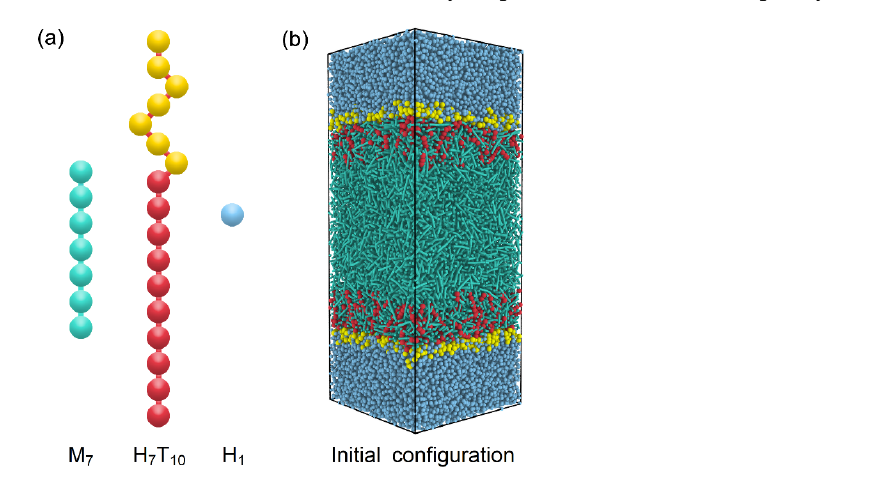
Figure 1. Schematic illustrations of ( a ) coarse-grained models of mesogens (M 7 ), amphiphiles (H 7 T 10 ) and water (H 1 ) and ( b ) initial configuration of DPD simulations. Accordingly, there are three types of DPD beads (M, H and T) involved in the present study. For the same type, 𝑎 (cid:3014)(cid:3014) (cid:3404) 𝑎 (cid:3009)(cid:3009) (cid:3404) 𝑎 (cid:3021)(cid:3021) (cid:3404) 20 is set according to 𝑎 (cid:3036)(cid:3036) (cid:3404)